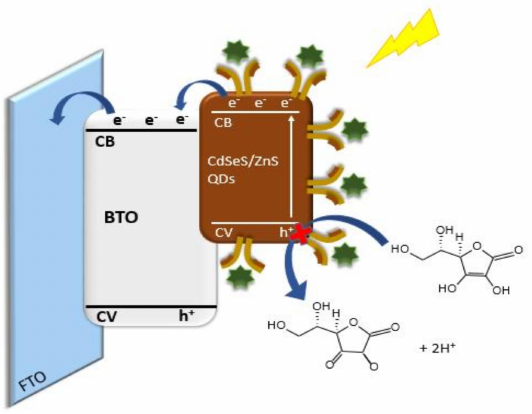
Scheme 1. Schematic representation proposed for Mb detection using the anti-Mb/CdSeS/ZnS QDs/BTO/FTO photoelectrochemical